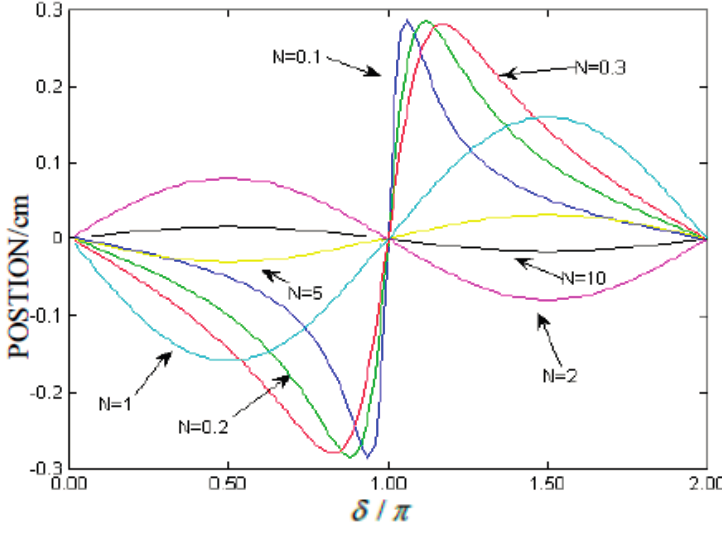
Figure 3. PSD readings versus interference fringes phase difference for some values of